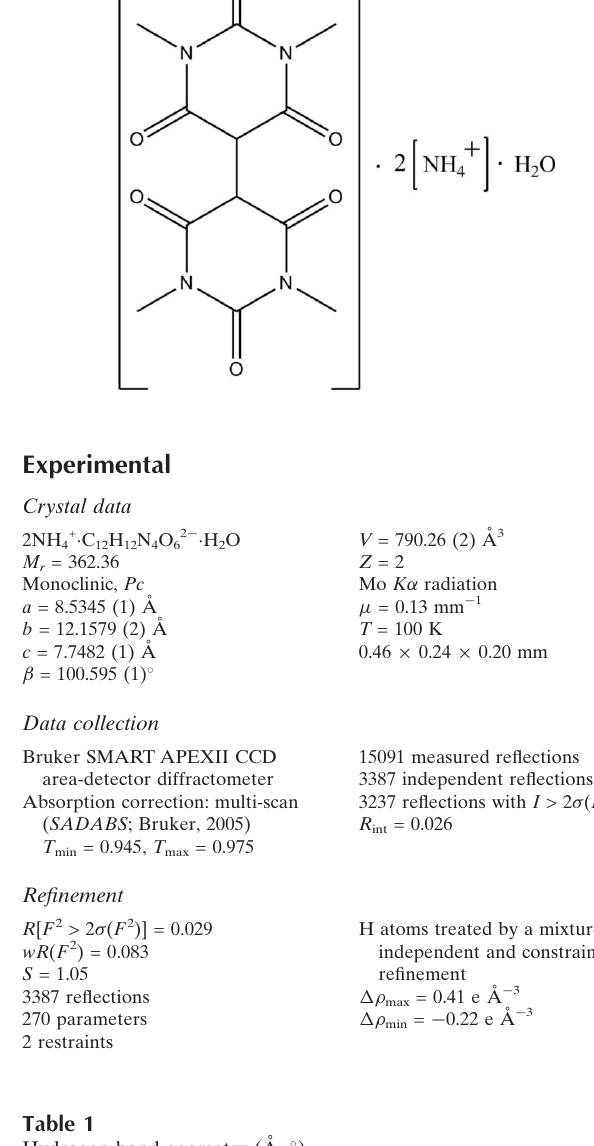
Hydrogen-bond geometry (A˚ , (cid:4)